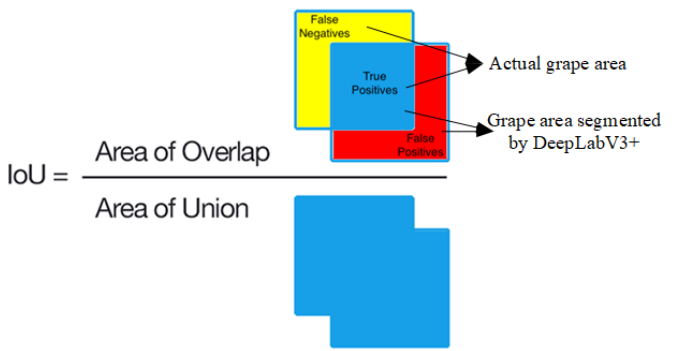
Figure 20. The meaning of the IoU metric.